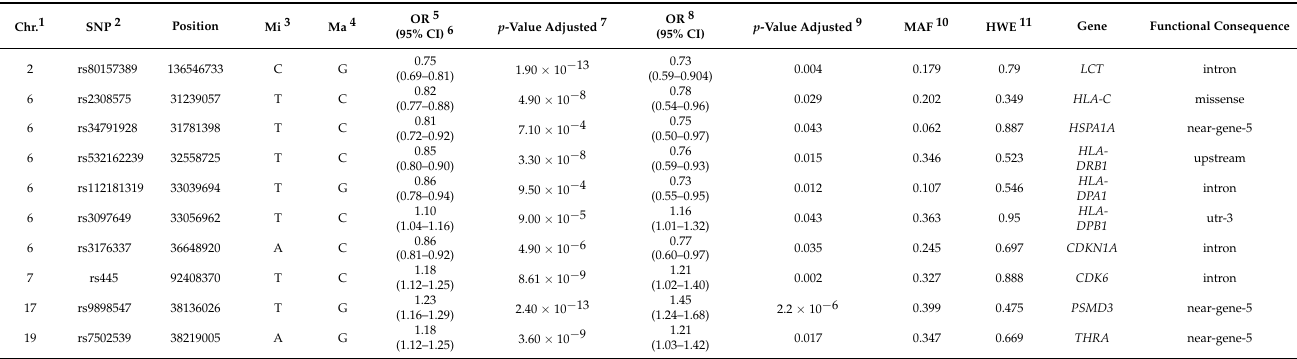
1 Chromosome; 2 single nucleotide polymorphism; 3 minor allele; 4 major allele; 5 odds ratio (OR) for the hospital-based large cohort (case, n = 4176 and control, n = 36,551); 6 lower and upper end of 95% confidence interval (CI); 7 p -value for OR in the hospital-based large cohort after adjusting for age, gender, residence area, survey year, body mass index, daily energy intake, education, and income in Nutrients 2021 , 13 , x FOR PEER REVIEW logistic regression analysis; 8 OR for the Ansan/Ansung cohort; 9 p -value for OR in Ansan/Ansung cohort (case, n = 207; control, n = 5286); 10 minor allele frequency; 11 p -value for Hardy-Weinberg equilibrium.